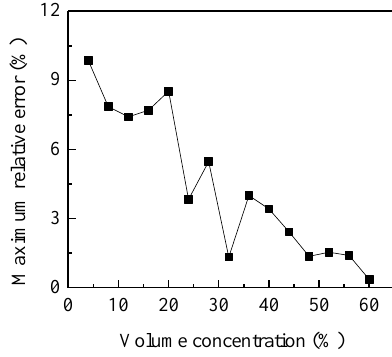
Figure 13. Maximum relative errorof the output voltageto the average value.